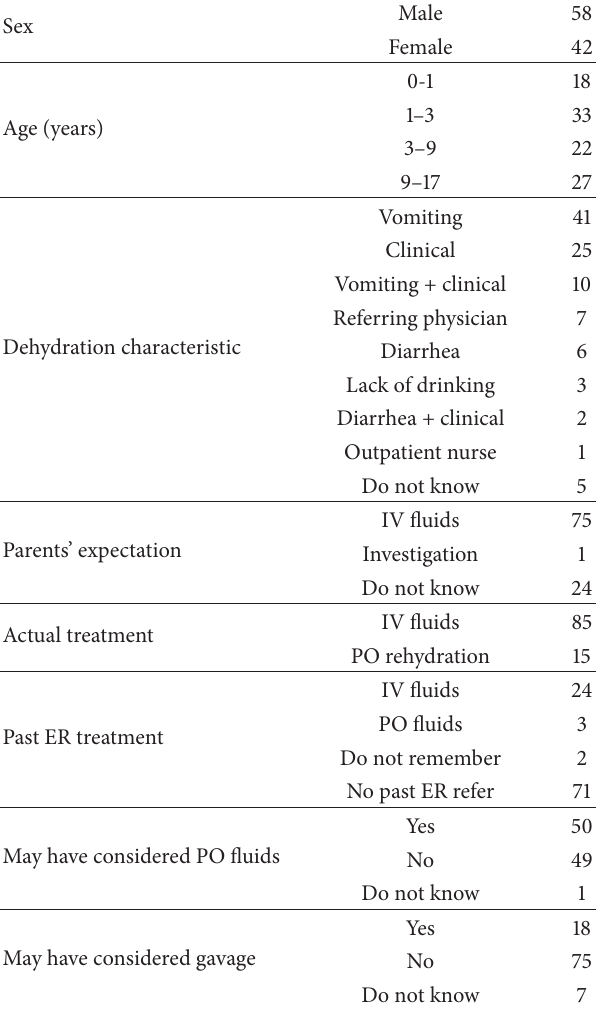
Table 1: Characteristics of the